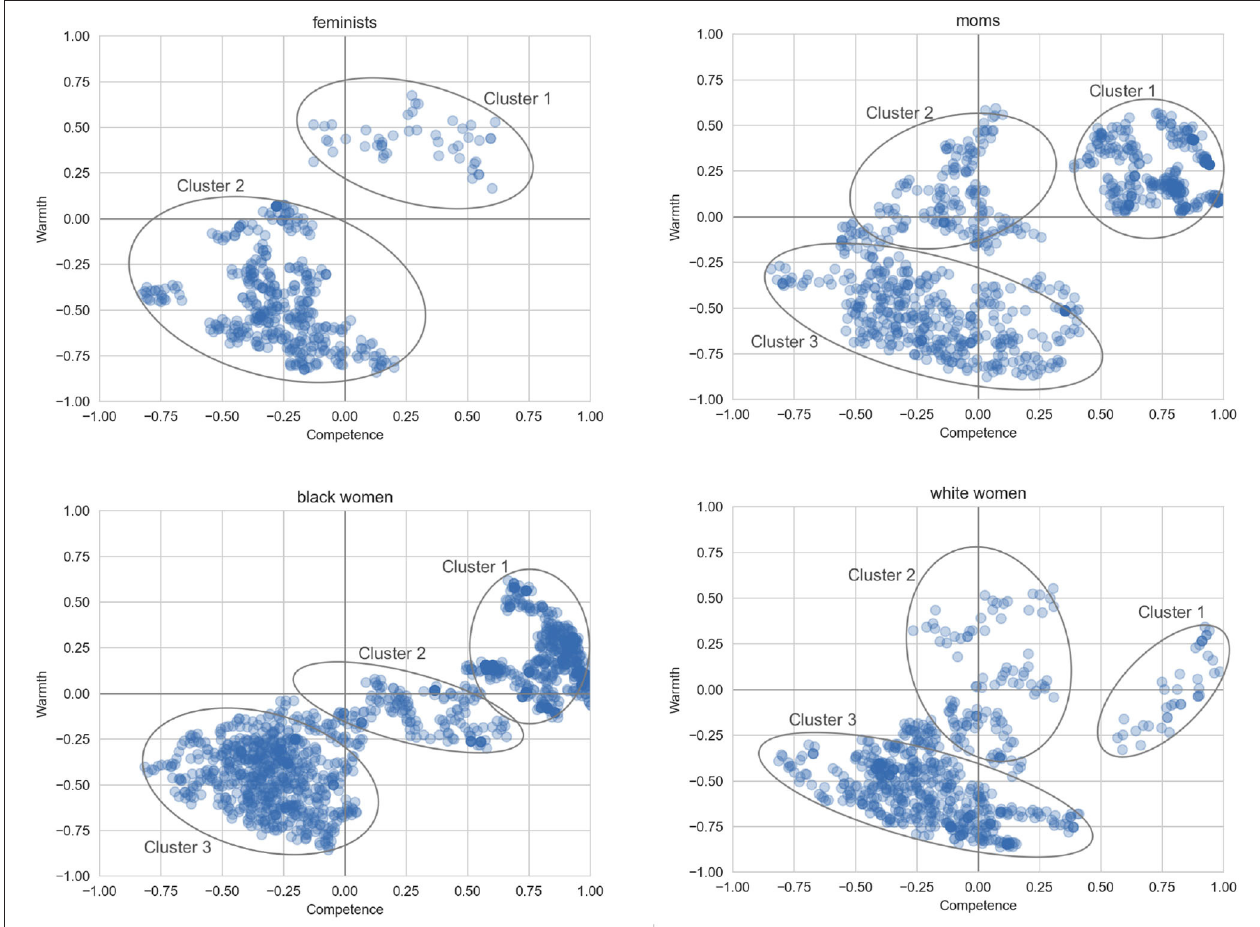
FIGURE 4 | Areas of highest density for the different groups of